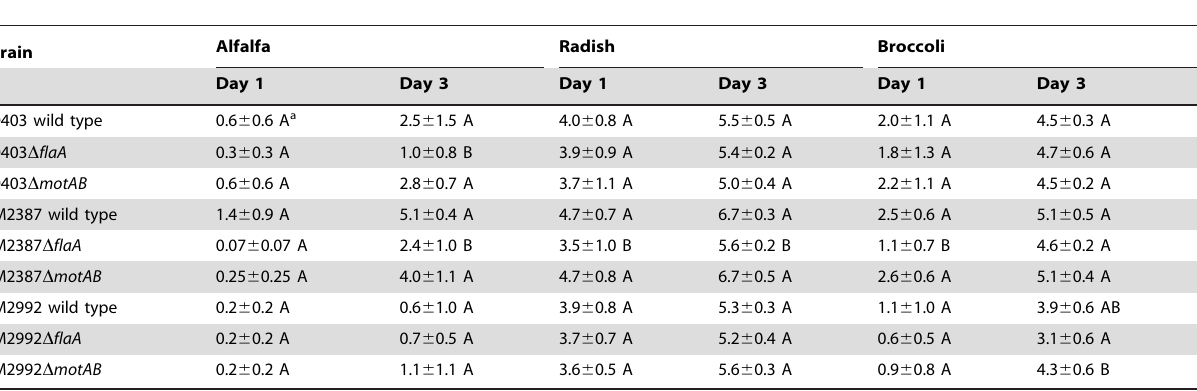
Table 1. Number (log CFU/sprout) of the different L. monocytogenes on sprouts after 1 and 3 days of growth.